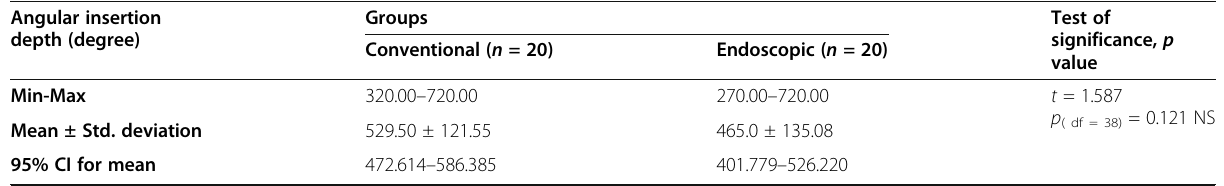
Table 4 The angular insertion depth in degree between the studied groups which ranged from 320 to 720° in the conventional group and 270 to 720° in the endoscopic group, a difference that was not found to be statistically significant Angular insertion depth (degree)